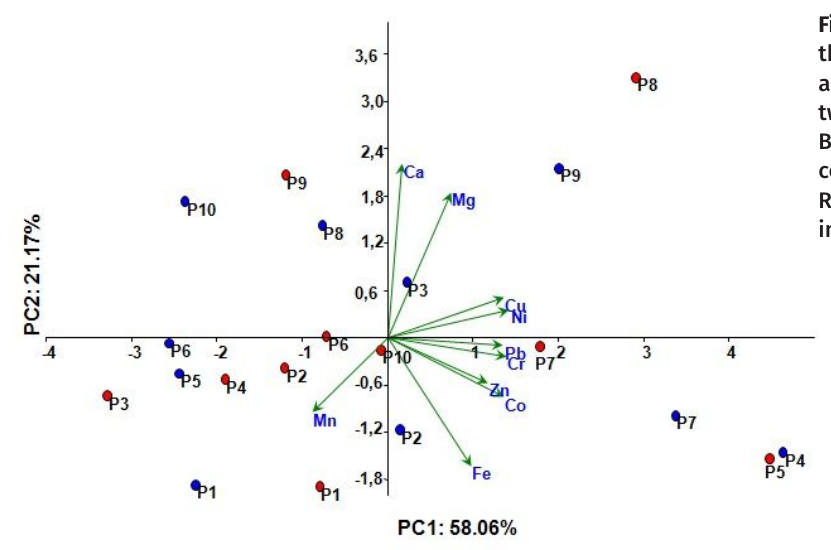
Figure 4. Bi-plot obtained by the overlapping of the scores and loadings graphs for the two sampling campaigns. Blue points: samples collected in the dry season. Red points: samples collected in the rainy